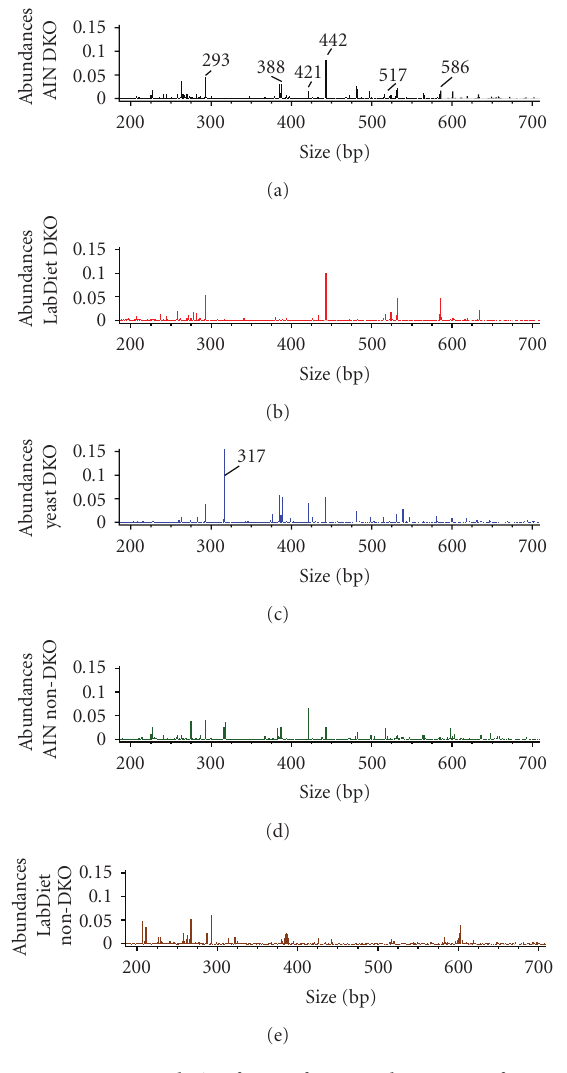
Figure 6: ARISA analysis of DNA from cecal contents of 129 N5. This DKO colony was established by backcrossing the mixed strain B6;129 colony to 129Sv/J for 5 generations. The plots were generated from 15DKO mice on AIN diet (AINDKO), 18 DKO mice on LabDiet (LabDietDKO), 7DKO mice on AIN diet supplemented with 1% yeast (Yeast DKO), 13 non-DKO mice on AIN diet (AIN non-DKO), and 13 non-DKO mice on LabDiet (LabDiet non- DKO). Non-DKO mice were the sibs of DKO mice, heterozygous for Gpx1 and/or Gpx2 (thus no inflammation). DKO mice on LabDiet did not have the distinctive peaks at 385–390 bp, 421 bp, 481bp, and 498 bp found in other groups. DKO mice on the yeast- containing diet had a similar profile as AIN-fed mice, except having a prominent 317bp peak. The 442 bp ribotype found in these 129 N5 DKO mice had lower abundance in the non-DKO sibs on both LabDiet and AIN diets.